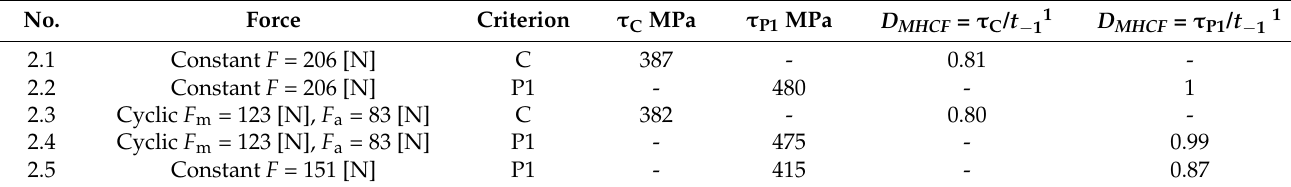
Table 5. Results obtained by using the multiaxial high-cycle fatigue criteria for a roller bearing subjected to constant and cyclic